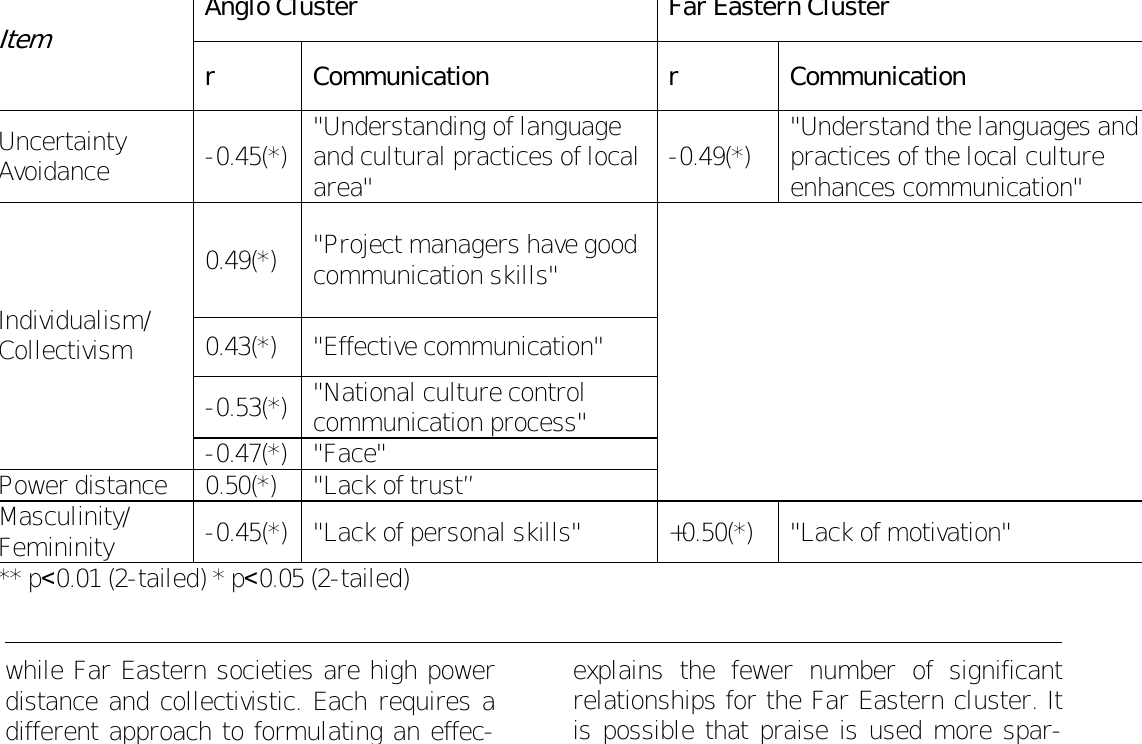
Table 5: Correlations between National Dimensions and Communication Variables Anglo